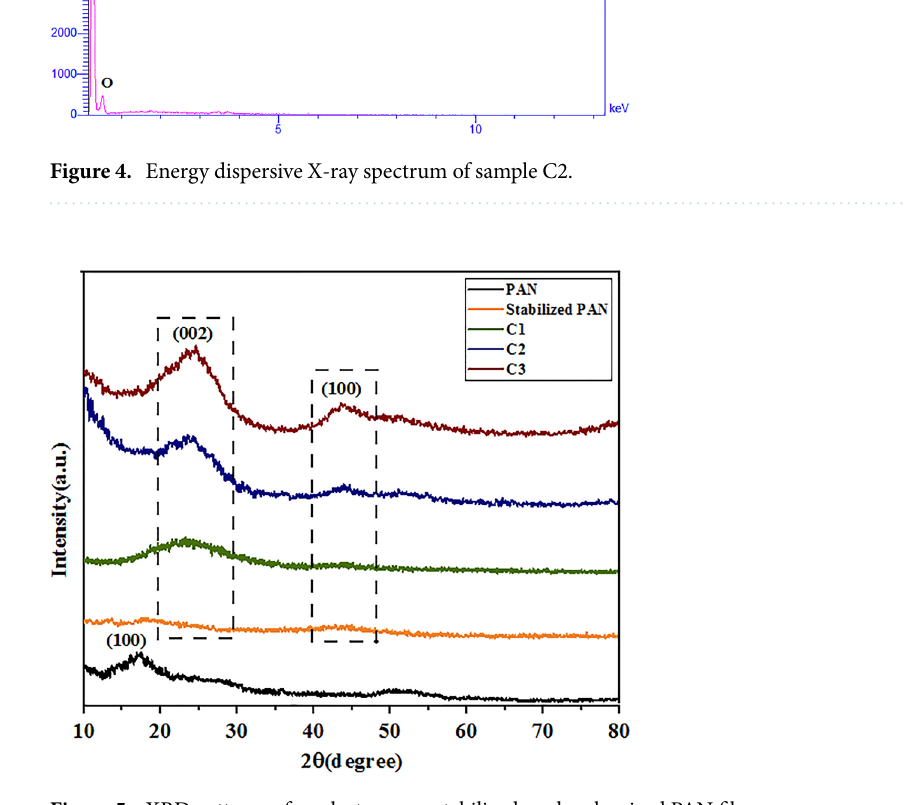
Figure 5. XRD patterns of as-electrospun, stabilized, and carbonized PAN